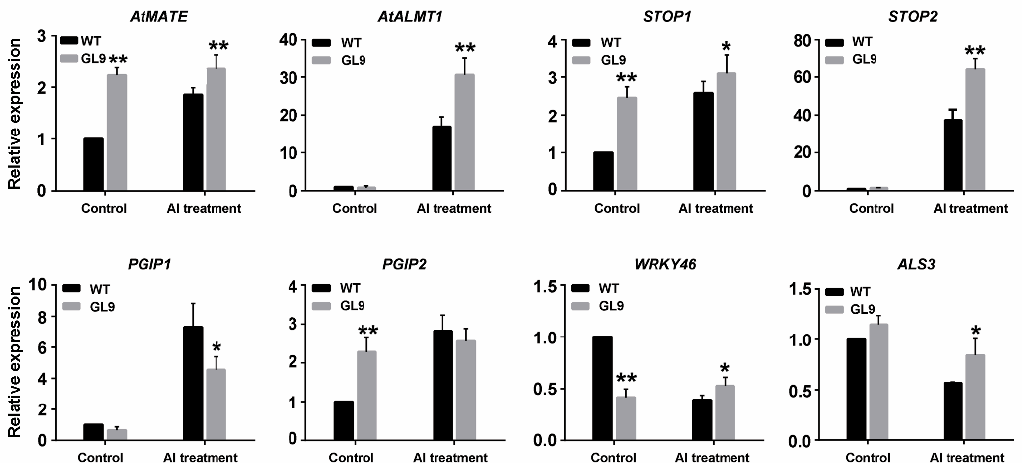
Figure 6. Expression patterns of Al stress responsive genes regulated by GsMAS1. Arabidopsis seeds of WT and the GsMAS1 transgenic line L9 of T 3 generation were sown in 1 / 2 MS (Murashige-Skoog) culture media and cultured in the chamber room. The two-week-old seedlings were subjected to the treatment of solutions with or without 50 µ M AlCl 3 (pH 4.3, 0.5 mM CaCl 2 ) for 24 h. The seedling samples from Arabidopsis plants were taken to extract total RNA. The transcription abundance of investigated genes was quantified by qRT-PCR using ACT3 as the inner reference gene. The quantitative variation between the examined replicates was determined by the 2 − ∆∆ Ct method. The details of specific primers for GsMAS1 , ACT3 and measured genes are listed in Table S1 (Additional file 3). WT: wild type; GL9: GsMAS1 transgenic line L9 of T 3 generation. The data were represented as the mean ± SE of three biological replicates (t-test, ** p =